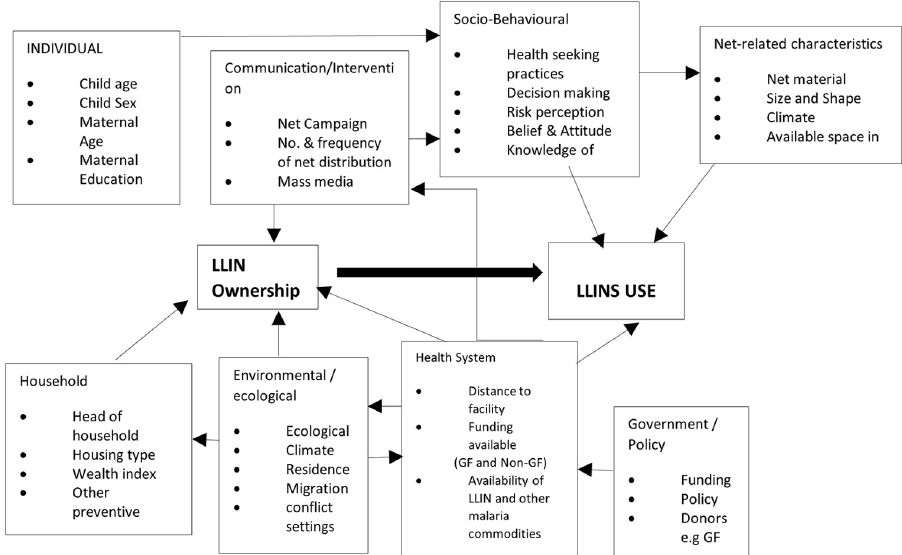
Data analysis. Based on the comparison of parasitaemia prevalence between NMIS 2015 and NDHS 2018, states were classified into two groups- those with an increase in parasitaemia and those with a reduction. After that, we analysed 2018 NDHS data and presented results for (i) all the 13 States; (ii) Four States with increased parasitaemia (Gombe, Jigawa, Kano and Ogun) and (iii) Nine States with a reduction in parasitaemia (Adamawa, Delta, Kaduna, Katsina, Kwara, Niger, Osun, Taraba, and Yobe).